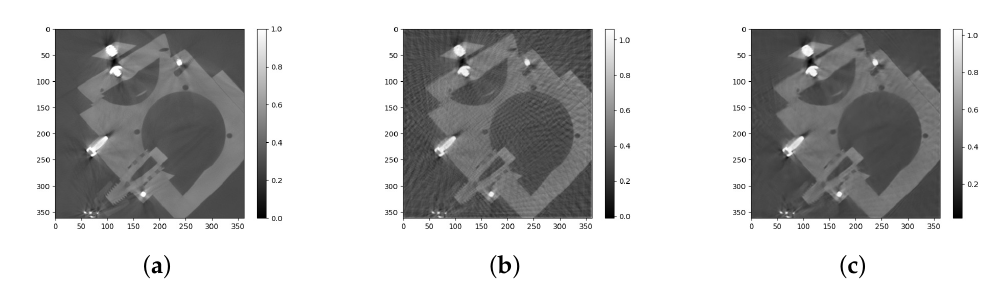
Figure 12. Comparison of different reconstruction methods.